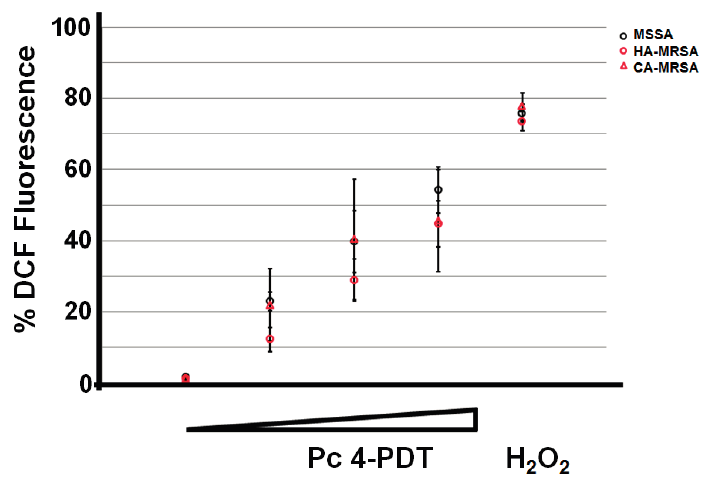
Figure 4. To monitor ROS generation by confocal microscopy and flow